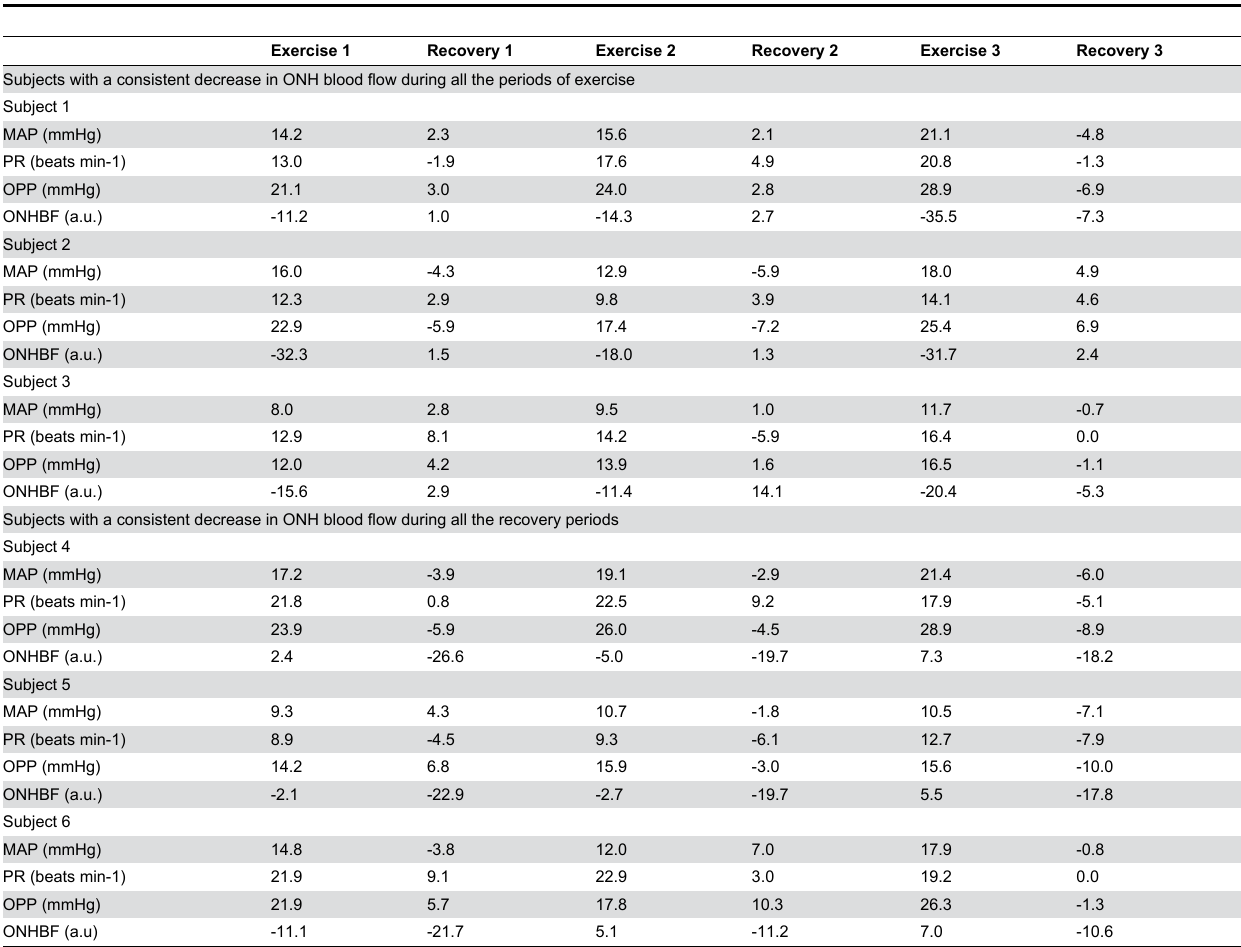
Table 5. Effects of isometric exercise (handgripping, 3 periods) on mean arterial pressure, pulse rate, ocular perfusion pressure, and optic nerve head blood flow in the subgroup of subjects that showed abnormal blood flow patterns either during (n=3) of after (n=3) isometric exercise defined as a decrease of more than 10% (individual data are presented as % change from